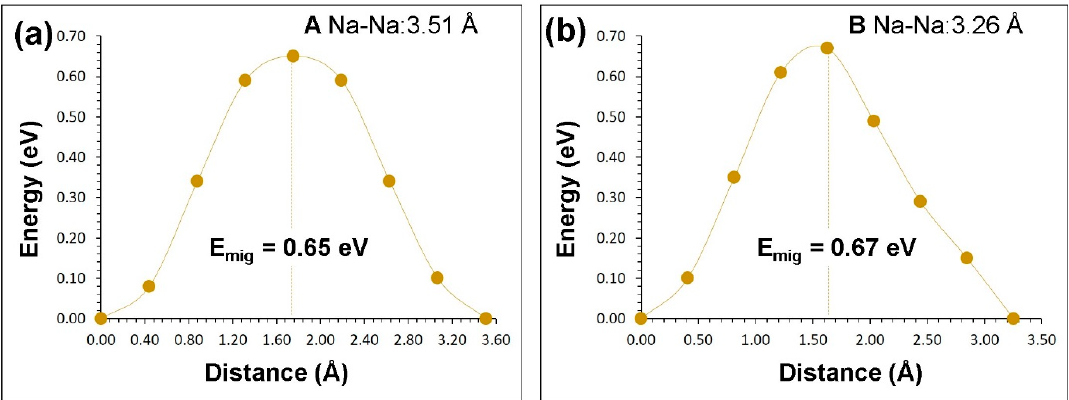
Figure 5. Energy profile diagrams (A and B as shown in Figure 4) for local Na vacancy hopping with Na-Na separation of ( a ) 3.51 Å and ( b ) 3.26 Å β -NaFeO 2 .